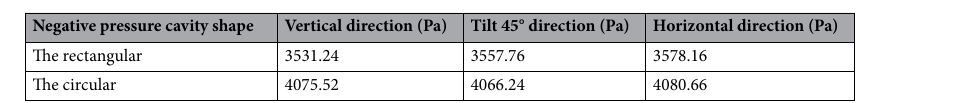
Table 3. Negative pressure values of different cavity